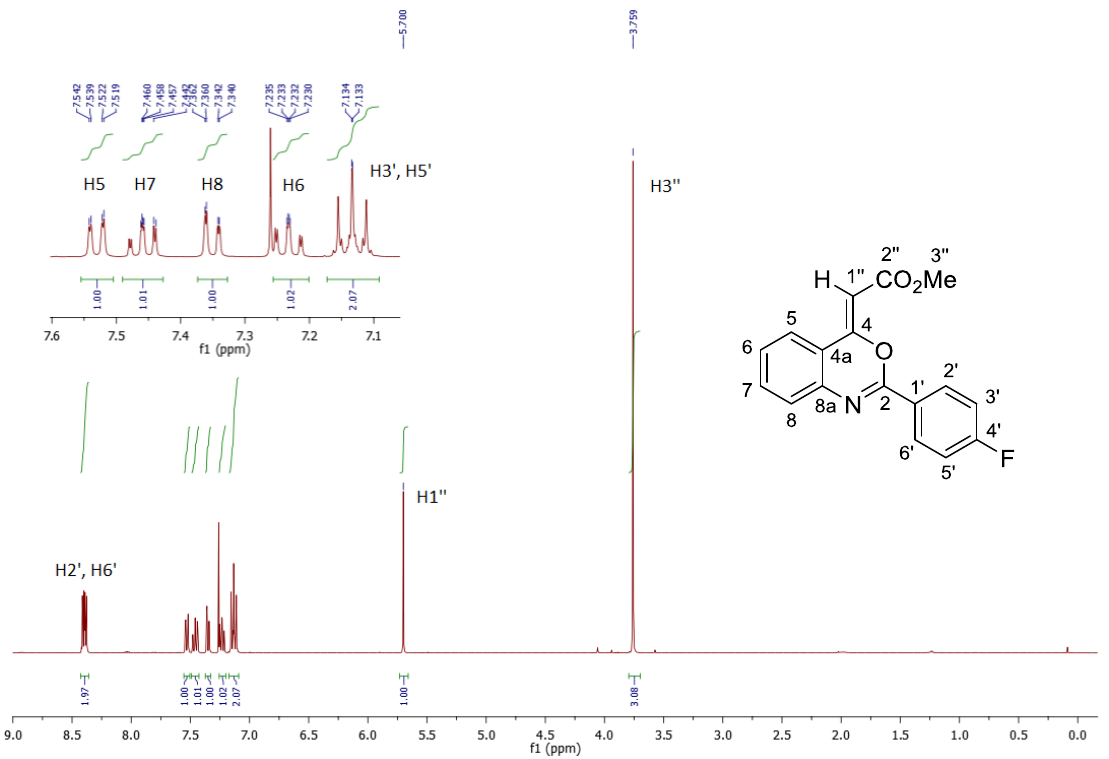
Figure 1. 1 H-NMR spectrum of compound 2 (400 MHz, CDCl 3 ) and related assignments.